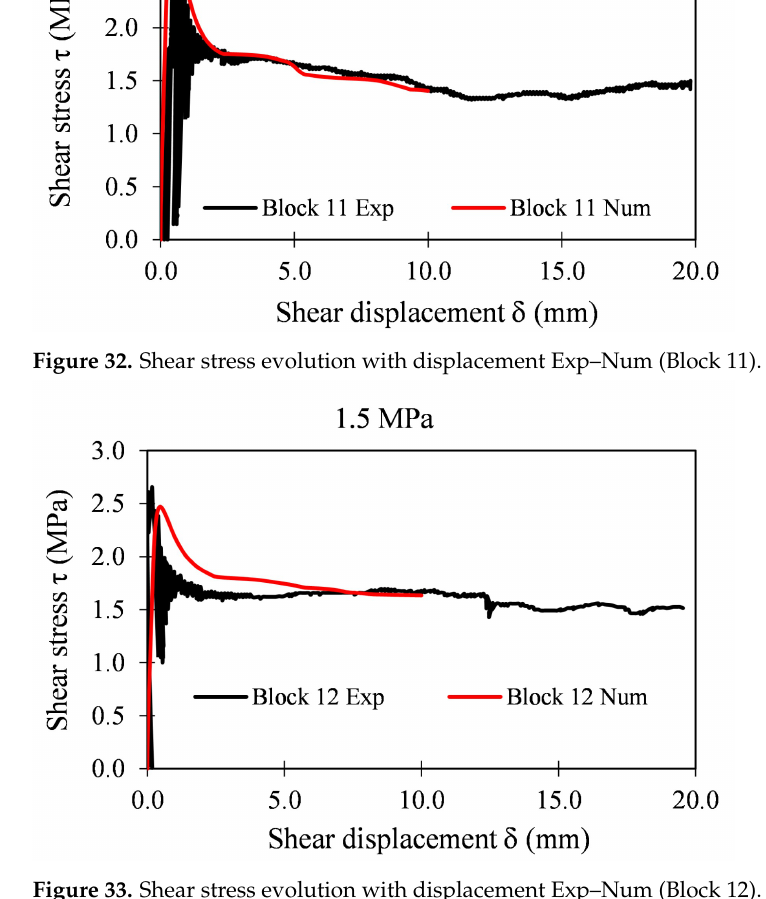
Figure 33. Shear stress evolution with displacement Exp–Num (Block